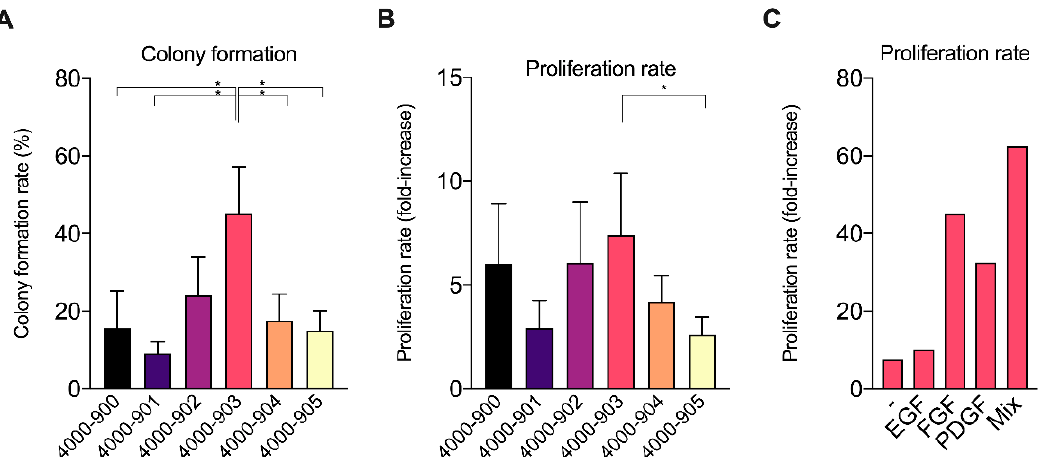
Figure 2. ( A ) The rate of spheroid colonies that formed and ( B ) fold increase of cells on different EZSPHERE ® dish types derived from 20,000 human nucleus pulposus cells ( n = 4) following 14 days of culture. ( C ) The fold-increase in cell numbers following culture of nucleus pulposus cells ( n = 1) on EZSPHERE ® dish type 4000-903, without (-) or with 100 ng/mL epidermal growth factor (EGF), 10 ng/mL fibroblast growth factor (FGF), 100 ng/mL platelet derived growth factor (PDGF), and a combination of all three growth factors (Mix). Data is presented as mean values with error bars presenting standard deviation. * p < 0.05,